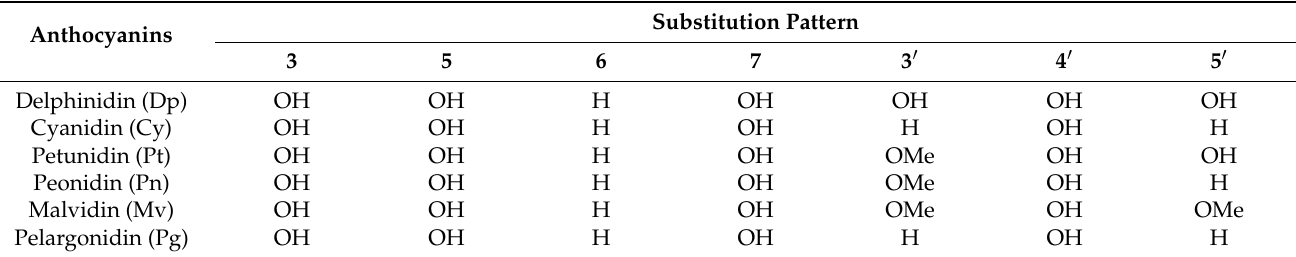
Figure 1. The basic structure of anthocyanins. A: A ring; B: B ring; C: C ring. 1 – 10 and 1 ′– 6 ′ : the number of the carbon atom. Table 1. Substitution of common anthocyanins.